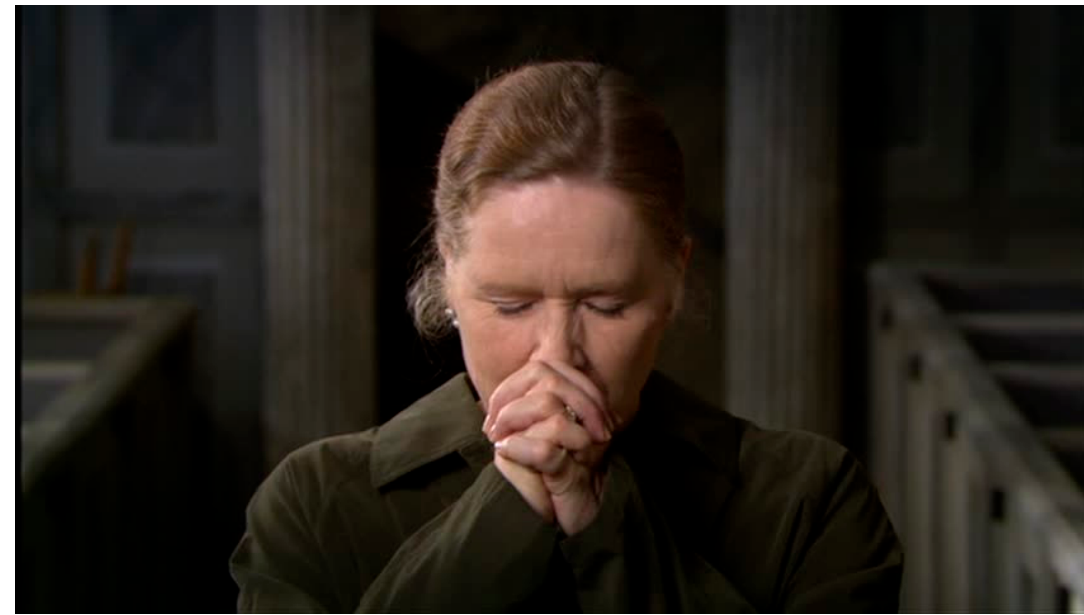
Figure 22. Light, Art, Prayer.